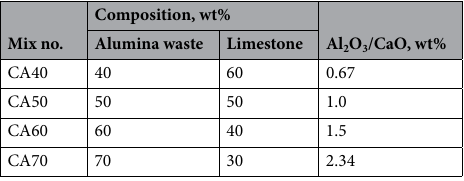
Table 2. Nominal compositions of the designed batches.